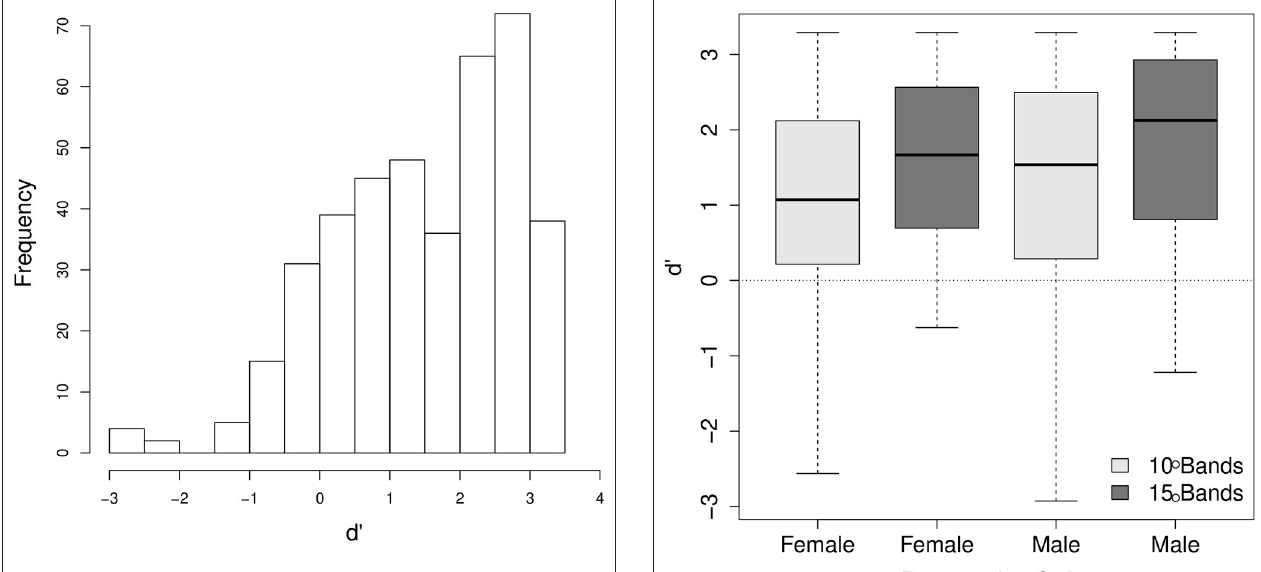
FIGURE 4 | The distribution of the mean d’ values for each listener for each word in each of the male or female voices.